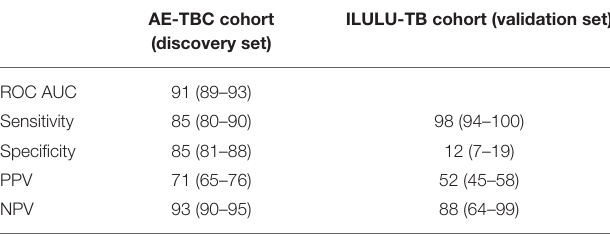
TABLE 4 | Performance of the seven-protein signature from the AE-TBC study in the ILULU-TB cohort.